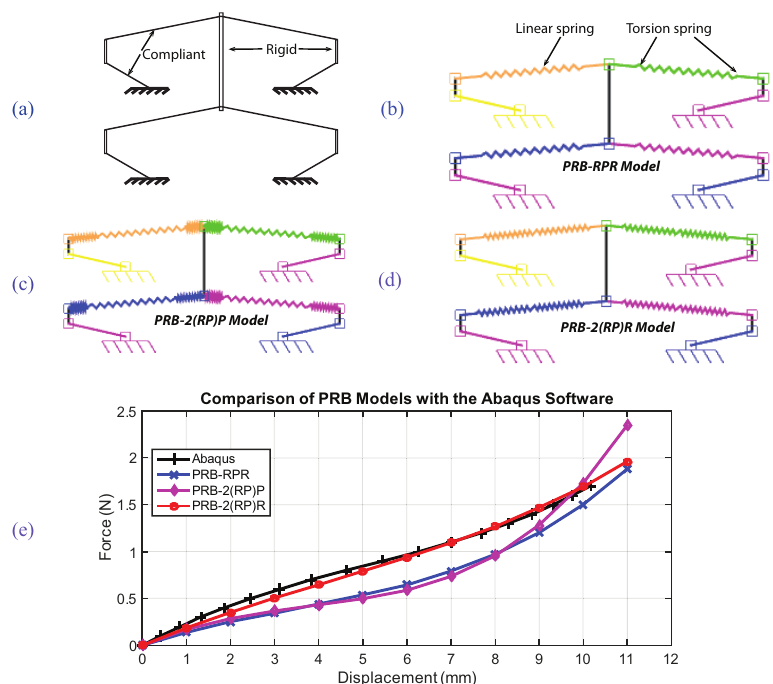
Figure 13. (a) A schematic view of the compliant mechanism consisting of four identical limbs each of which has two compliant beams joined with a rigid link. Panels (b) , (c) and (d) show the three different PRB models (PRB-RPR, PRB-2(PR)P, PRB-2(RP)R respectively). Comparison of the PRB model results with the Abaqus FSM result is shown in the panel (e) .